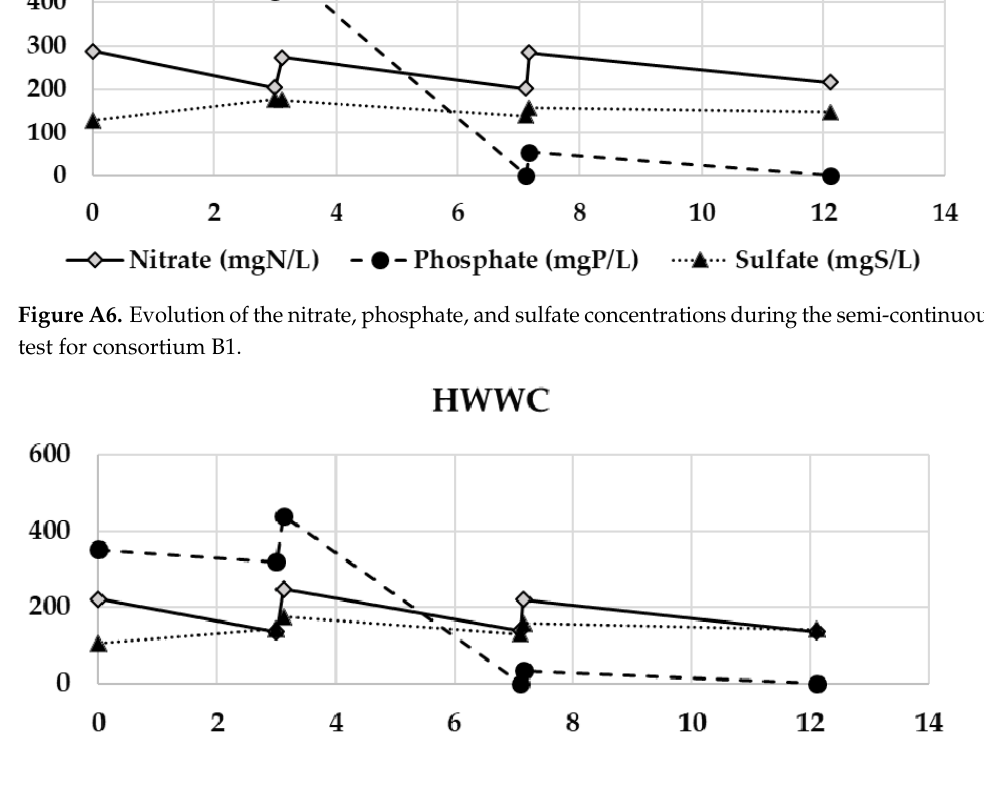
Figure A7. Evolution of the nitrate, phosphate, and sulfate concentrations during the semi-continuous test for HWWC.